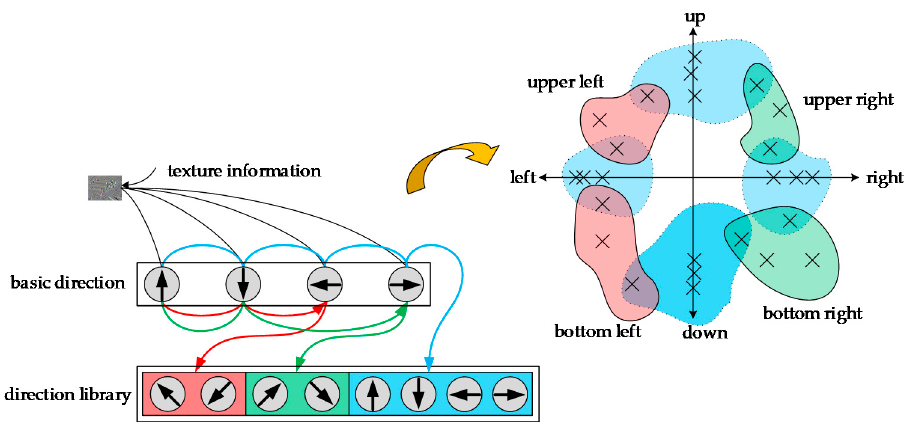
Figure 2. Schematic of recurrent neural network based on directional characteristics in texture features.